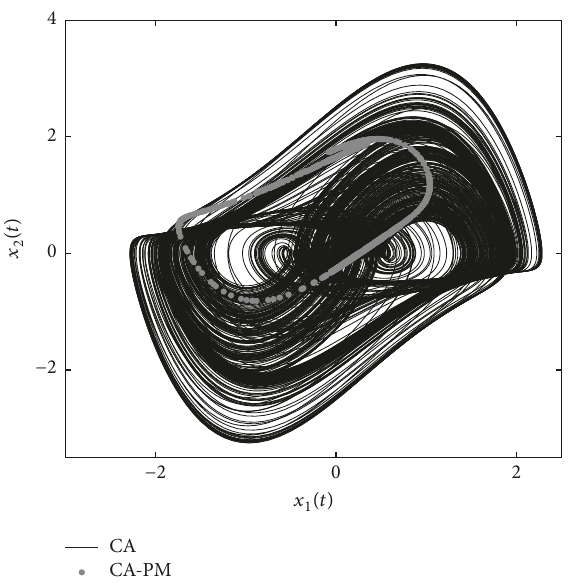
Figure 2: Forced van der Pol chaotic attractor in continuous-time (CA)andPoincar´emap(CA-PM)for 𝜔 = 0.45 , 𝜂 = 1 ,and 𝑎 = 0.988 .